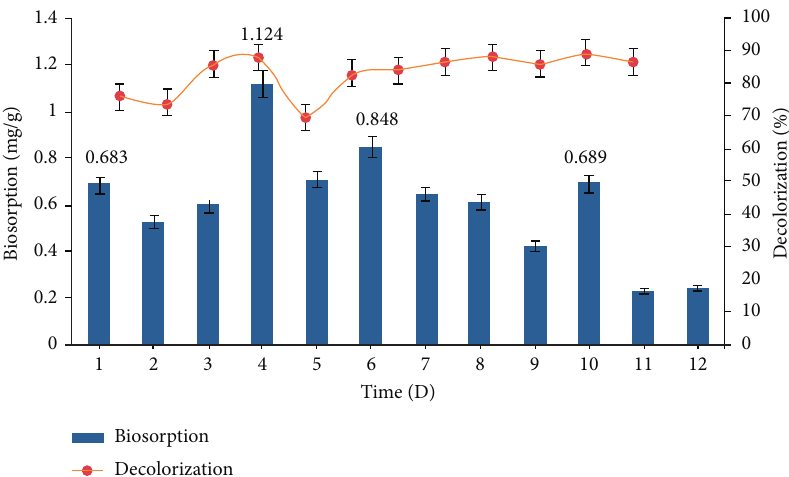
Figure 2: Proportionality of biosorption to the percentage of decolorization in the anaerobic treatment of synthetic textile effluent containing 100mg/L of mixed azo dyes in An-SBR.